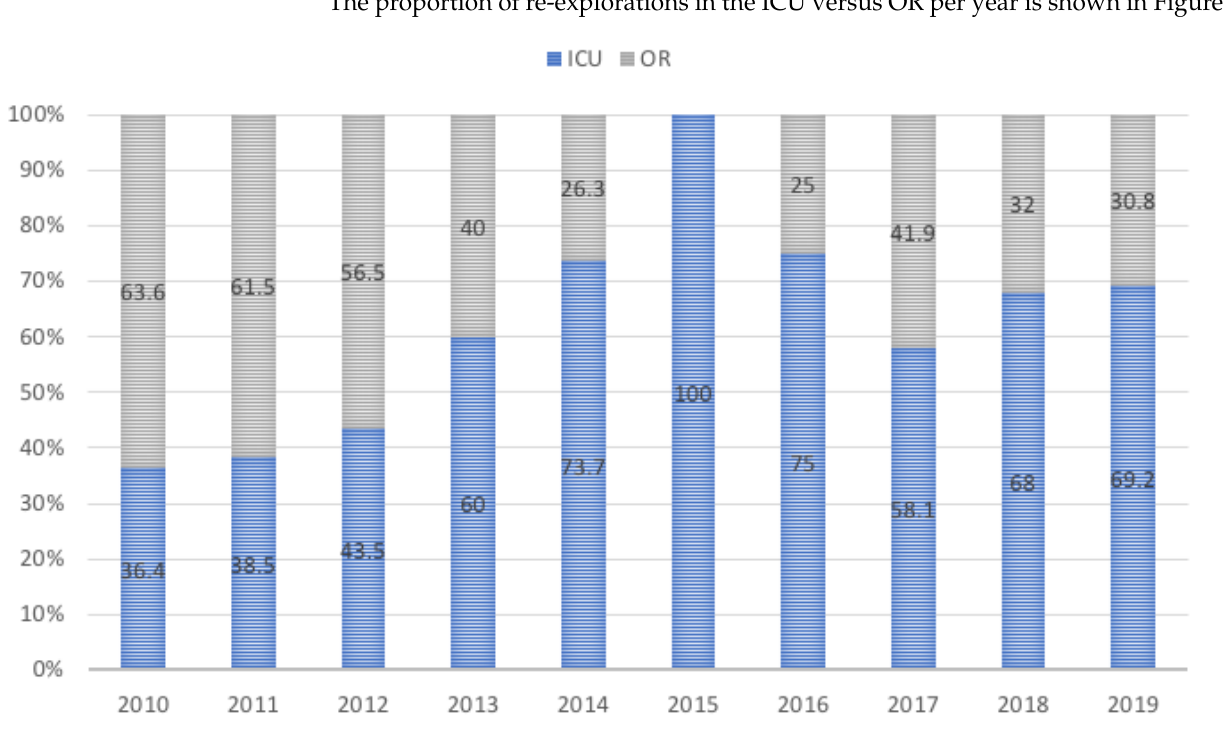
Table 1. Baseline characteristics and Intraoperative details.